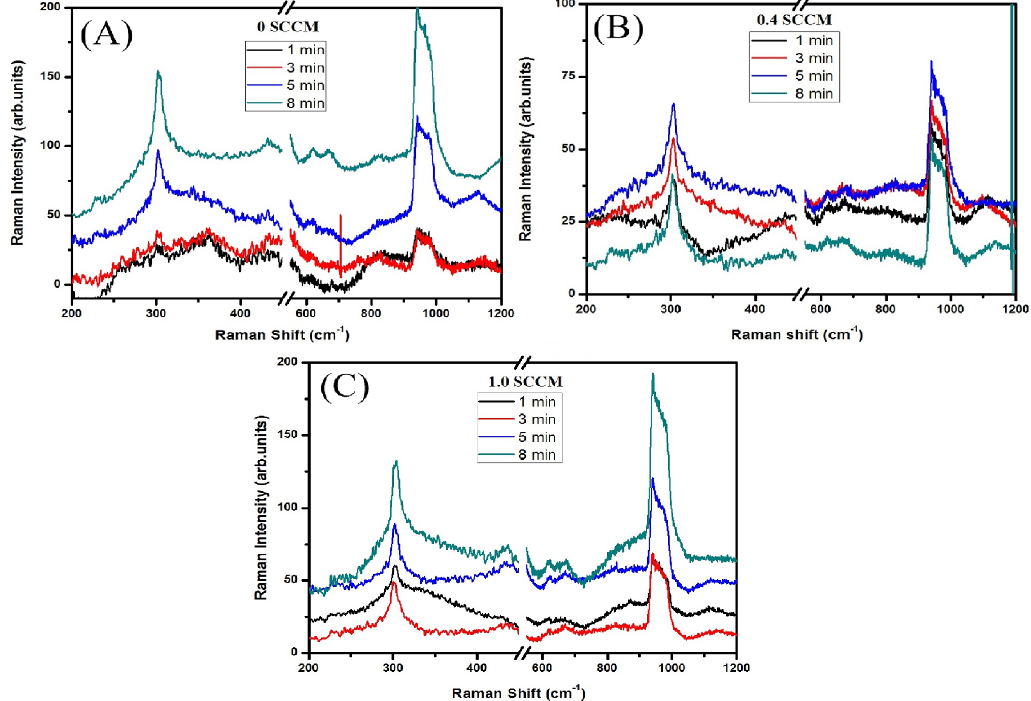
Figure 3. Raman spectra for the ITO films deposited under various oxygen concentrations and etched for 1, 3, 5 and 8 min., respectively. ( A ) 0 sccm; ( B ) 0.4 sccm; ( C ) 1.0 sccm.